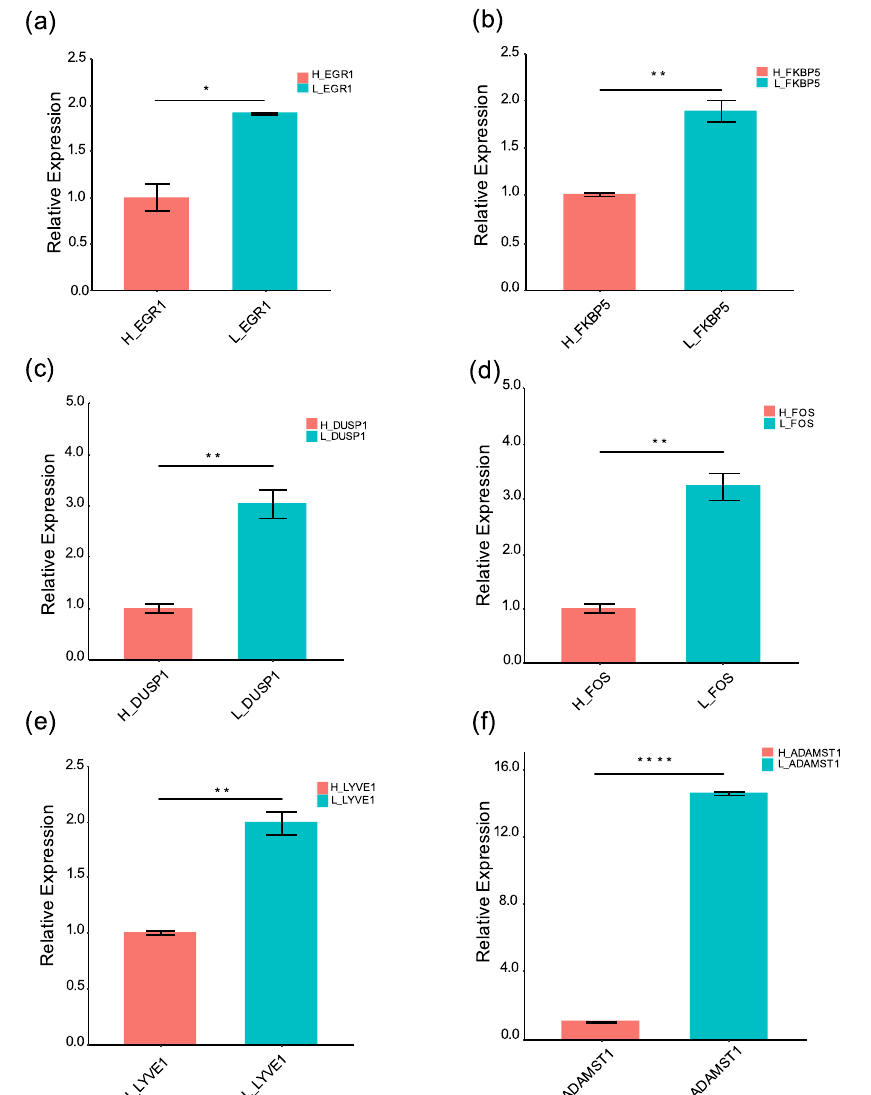
Figure 2. High-altitude stress reduced expression of hormone signaling transcription factors and lymphatic development marker genes. The relative expression pattern of EGR1 ( a ), FKBP5 ( b ), DUSP1 ( c ), FOS ( d ), LYVE1 ( e ), and ADAMST1 ( f ) in Tibetan sheep ovaries at low altitude and high altitude. The relative expression of each gene was detected by quantitative reverse transcription-PCR and normalized to GAPDH expression using the 2 –ΔΔCt method. Error bars represent standard deviation of three biological replicates. Y -axis: relative expression levels; X -axis: genes; H: high altitude; L: low altitude; “*” denoted the Student t -test p < 0.05; “**” denoted the Student t -test p < 0.01; “****” denoted the Student t -test p <